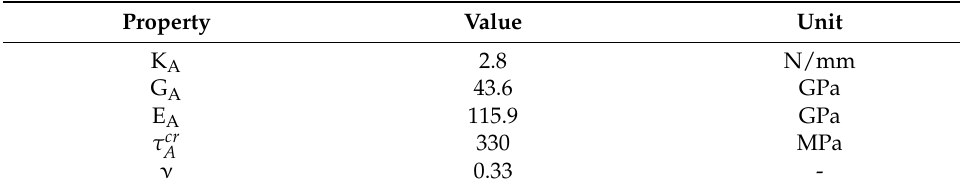
Figure 16. Geometrical arrangement and description of the investigated actuator (dimensions in mm).